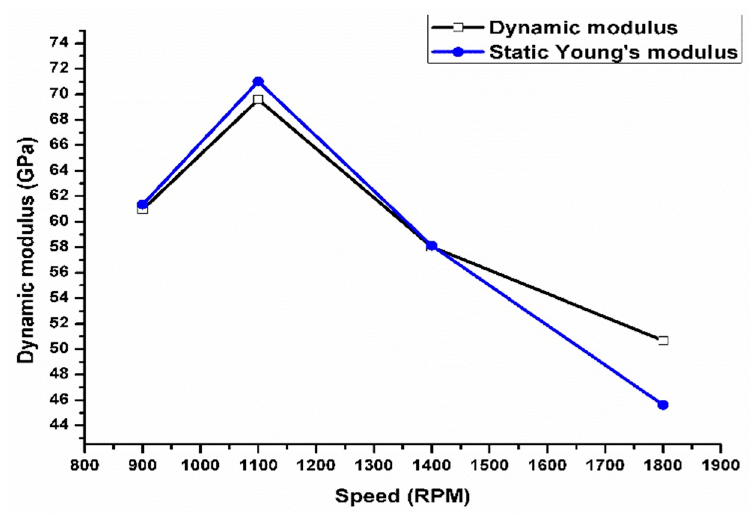
Figure 15. Convergence of static and dynamic moduli.